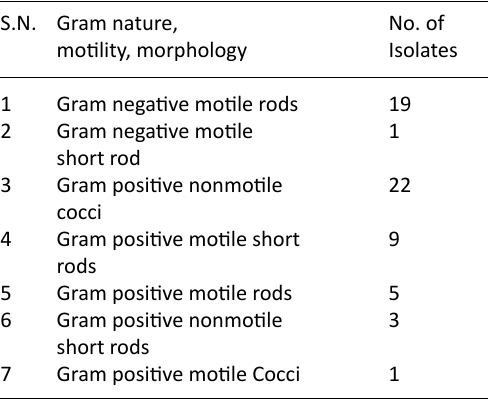
table 1. Characterization of psychrotrophic bacteria